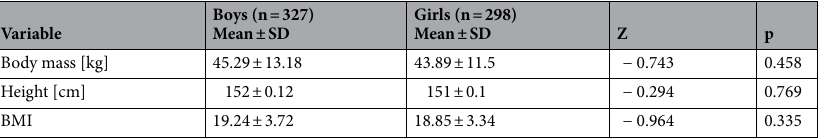
Table 1. Basic characteristics of the study subjects. Mean—arithmetic mean, SD—standard deviation, Z— statistical values of the Mann–Whitney–Wilcoxon test for two independent samples, BMI- body mass index, p-significance